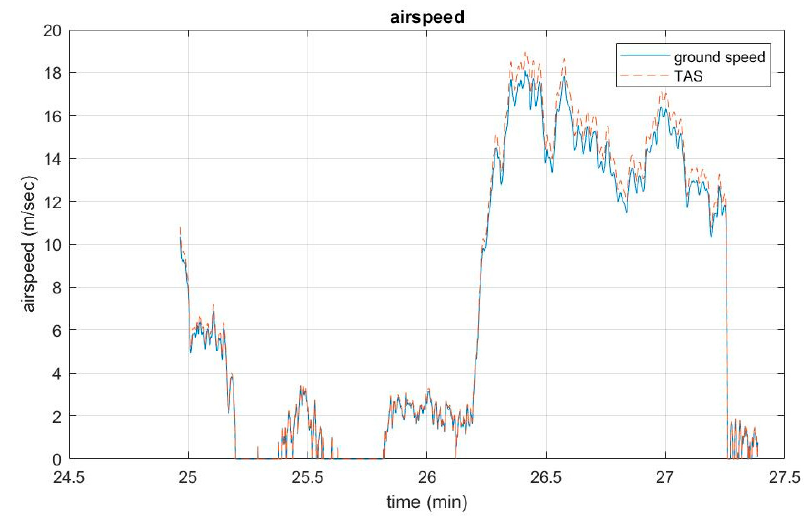
Figure 15. Airspeed in the first round of the second flight test (time = 24.5–27.5 s).